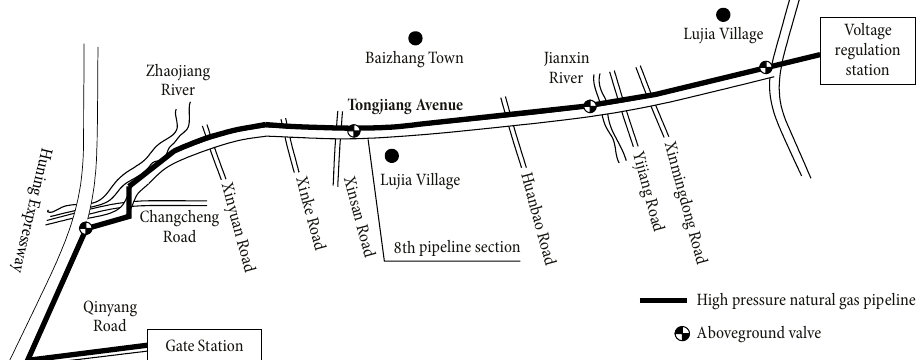
Fig. 10. The sketch of the high pressure natural gas pipeline